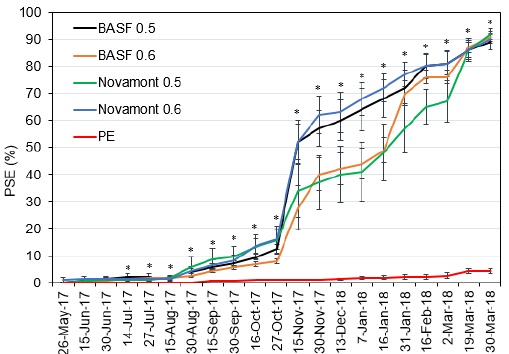
Figure 2. Percent soil exposure (PSE) of polyethylene (PE) and biodegradable plastic mulch (BASF and Novamont, where 0.5 and 0.6 indicate the film thicknesses: 0.5 mil = 12.7 µ m and 0.6 mil = 15.2 µ m) treatments applied in a raspberry field in May 2017. * indicates significant difference at p < 0.05 among treatments on the same date, using a nonparametric Wilcoxon multiple comparisons test at each time point. Values are the mean of 5 replications, and error bar is ± standard error.